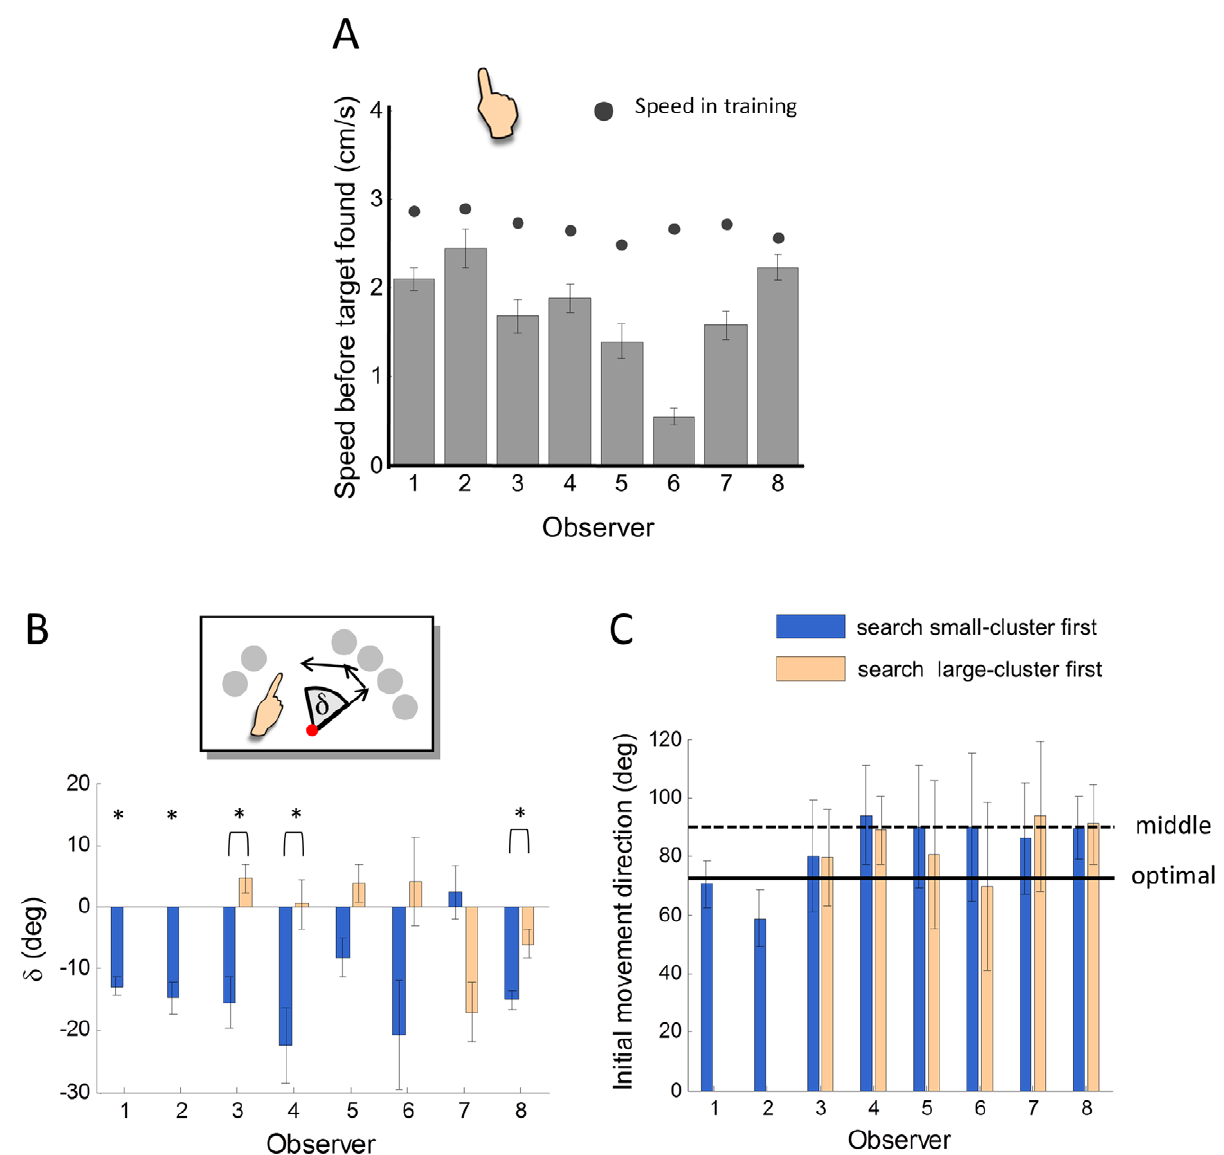
Figure 7. Hand movement strategies in the search-reach task. A. Mean movement speed before the target was found . Error bar denotes the 95% confidence interval. Before the target was found, if the observer did not move at all, it might cost her more than 30% of the rewards. Observers’ actual movement speed was significantly larger than zero, but six of the eight observers moved significantly and much slower than they did in the training of reach. B. The update of movement directions for different orders of visual search . In a trial where the observer searched no fewer than three objects before locating the target, we compared the position of the finger at the end of fixating the third object with that of the first object. The difference of angle (inset), d , is plot separately for each observer and the search strategies of small-cluster first and large- cluster first. Positive for shifts towards the small cluster, negative for shifts towards the large cluster. Error bar denotes the standard error. The large- cluster first strategy for O1 and O2 had fewer than five valid trials and were not plot therefore. By the optimal hand movement strategy, the observer should shift towards the large cluster when searching the small cluster first, thus a negative d , and vice versa. Six of the observers (O1 , O6) showed such a tendency. When searching small cluster first, five observers shifted significantly more towards the large cluster than that of large-cluster first, or significantly towards the large cluster (for observers who had not a large-cluster first comparison). Stars denote significant difference. C. Mean initial movement direction for different orders of visual search . For each trial with no less than one object searched before the target, the initial movement direction was defined as the direction from the starting position to the position of the finger at the end of fixating the first object. The direction was quantified in a polar coordinate centered at the starting position. The direction to the right was 0 degree; to the up, 90 degrees; to the left, 180 degrees. Error bar denotes the 95% confidence interval. The solid line denotes the optimal initial movement direction, which is towards the centroid of the six objects. The dash line denotes the middle of the two clusters. There was no significant difference in initial movement direction between the search orders. According to the mean initial movement direction, only two of the eight observers did not deviate significantly from optimal, while six of them were indistinguishable from a possible strategy of moving towards the middle of the two